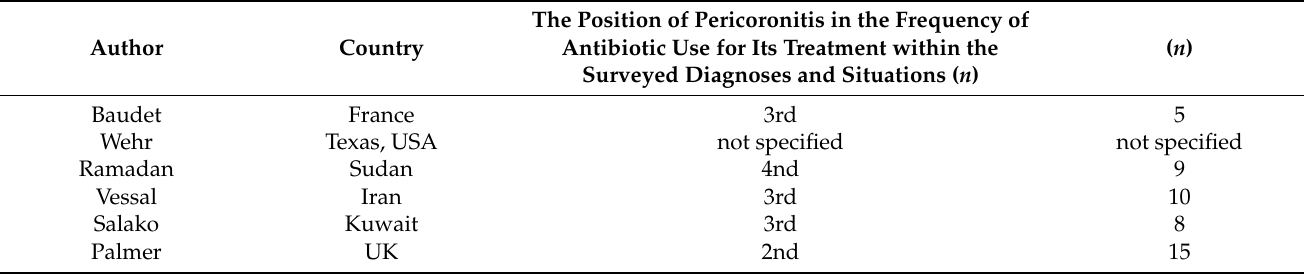
Table 7. The position of pericoronitis in the frequency of antibiotic use for its treatment within the surveyed diagnoses and situations.